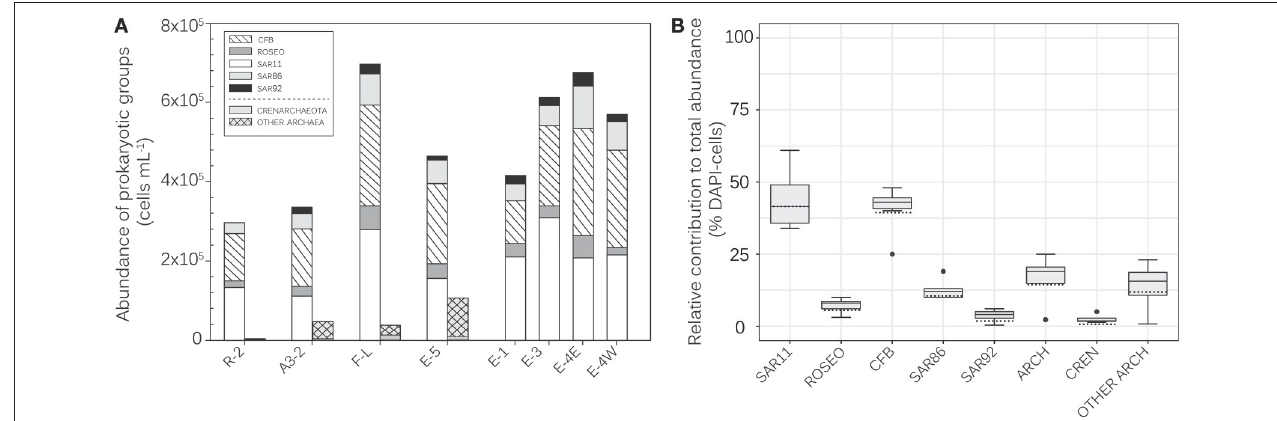
FIGURE 2 | Absolute (A) and relative (B) abundances of prokaryotic groups in surface waters of the study region. Except for Station E-5, no Archaea data are available for the E-sites. The black and the dashed lines across the box represent respectively the median and the mean. The ends of the boxes define the 25th and 75th percentiles and error bars define the 10th and 90th percentiles (data pooled from all stations shown in A ). Outliers are plotted in black dots. Values for “other Archaea” were calculated as the difference between Archaea and Crenarchaeota. ARCH, Archaea; CREN, Crenarchaeota; CFB, Cytophaga/Flexibacter/Bacteroides; ROSEO, Roseobacter clade; SAR11, SAR11 cluster; SAR 86, SAR86 cluster; SAR92, SAR92